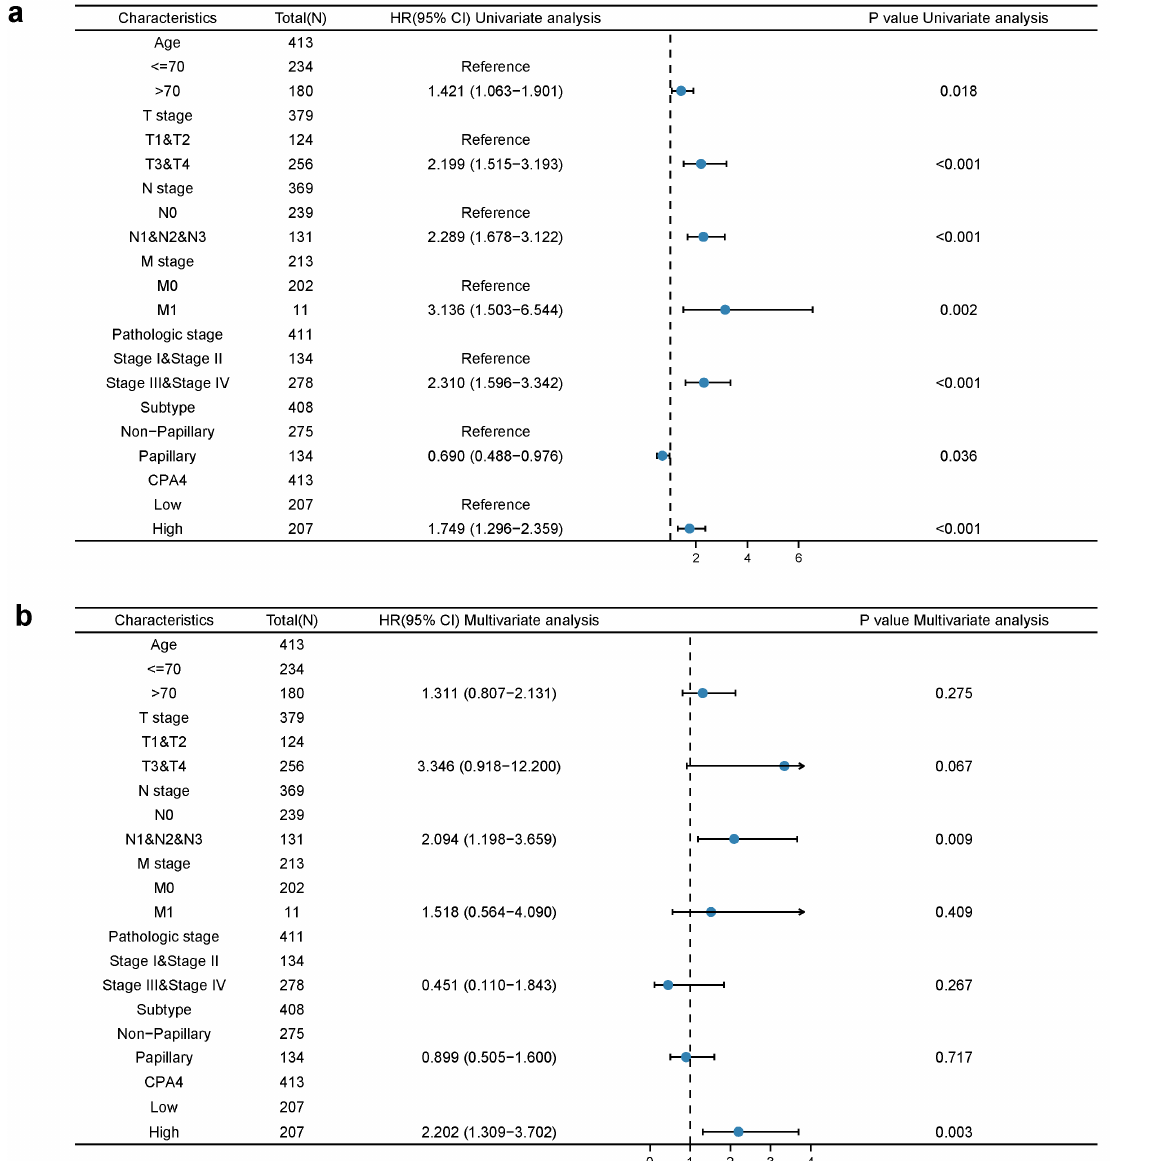
Figure 5. Univariate ( a ) and multivariate ( b ) regression analyses of CPA4 and other clinicopathologic parameters with OS in BLCA patients.